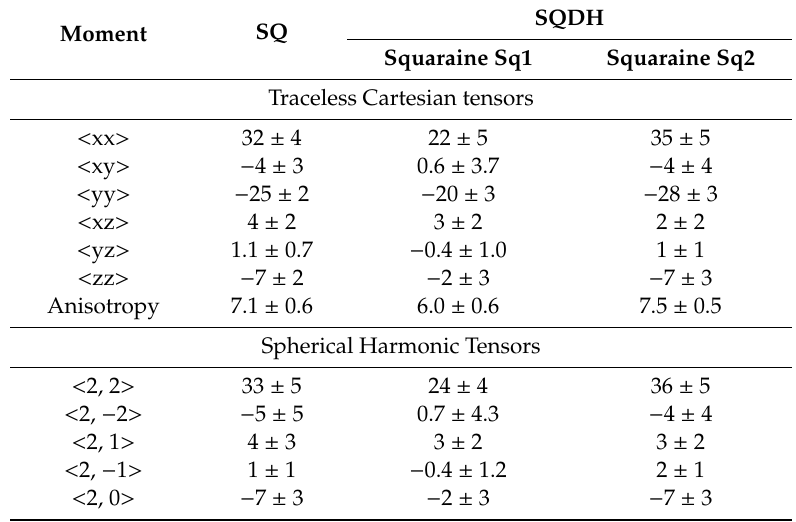
Table 9. Molecular Electrostatic Multipole Moments in units of Debye · Å. Individual components are referred to the eigen-axes of the inertial tensor, with origin in the molecular centre of